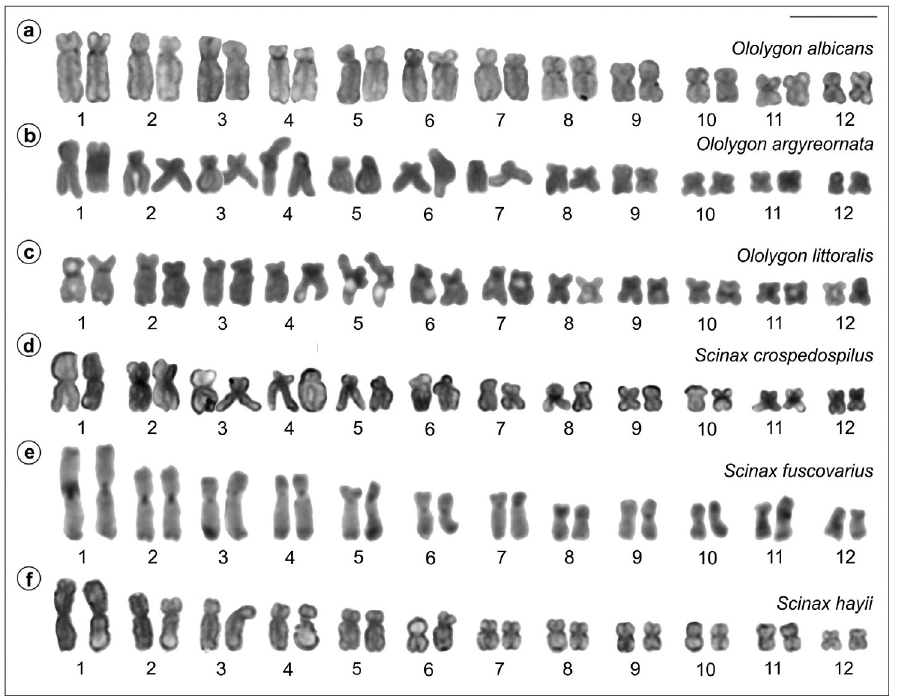
Figure 6. C-banding of Ololygon and Scinax species. a O. albicans b O. argyreornata c O. littoralis d S. cro-